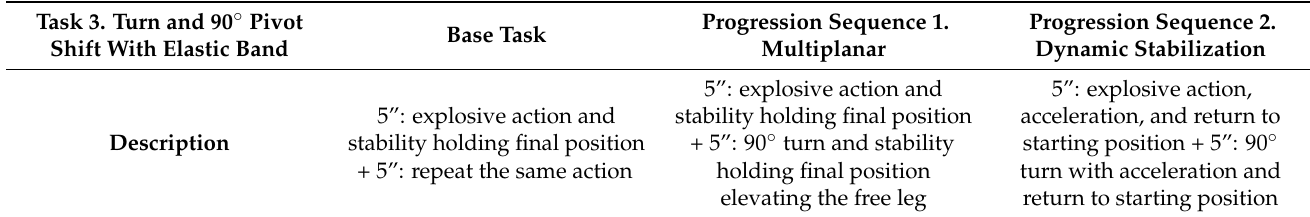
COD: change-of-direction. Table 3. Description and methodologic criteria of SCS group’s task 3 and its